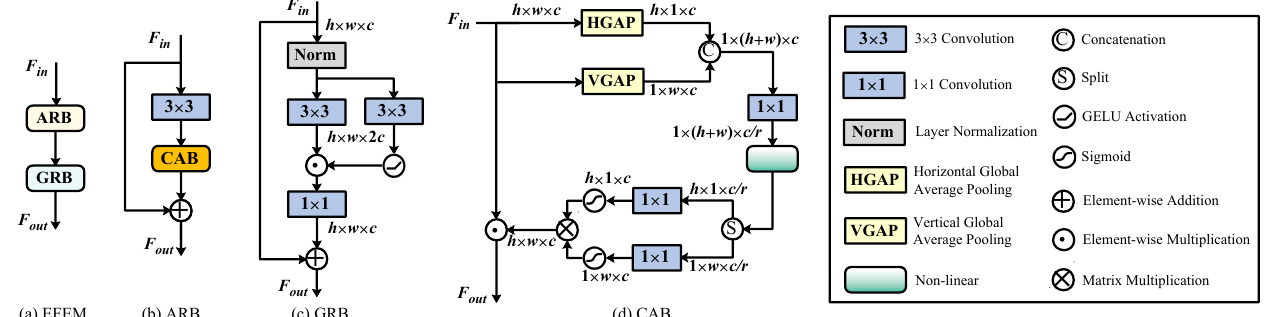
Figure 3. Detailed architecture of the modules in WaveCNN-CR: ( a ) enhanced feature extraction module, ( b ) attentive residual block, ( c ) gated residual block, and ( d ) coordinate attention